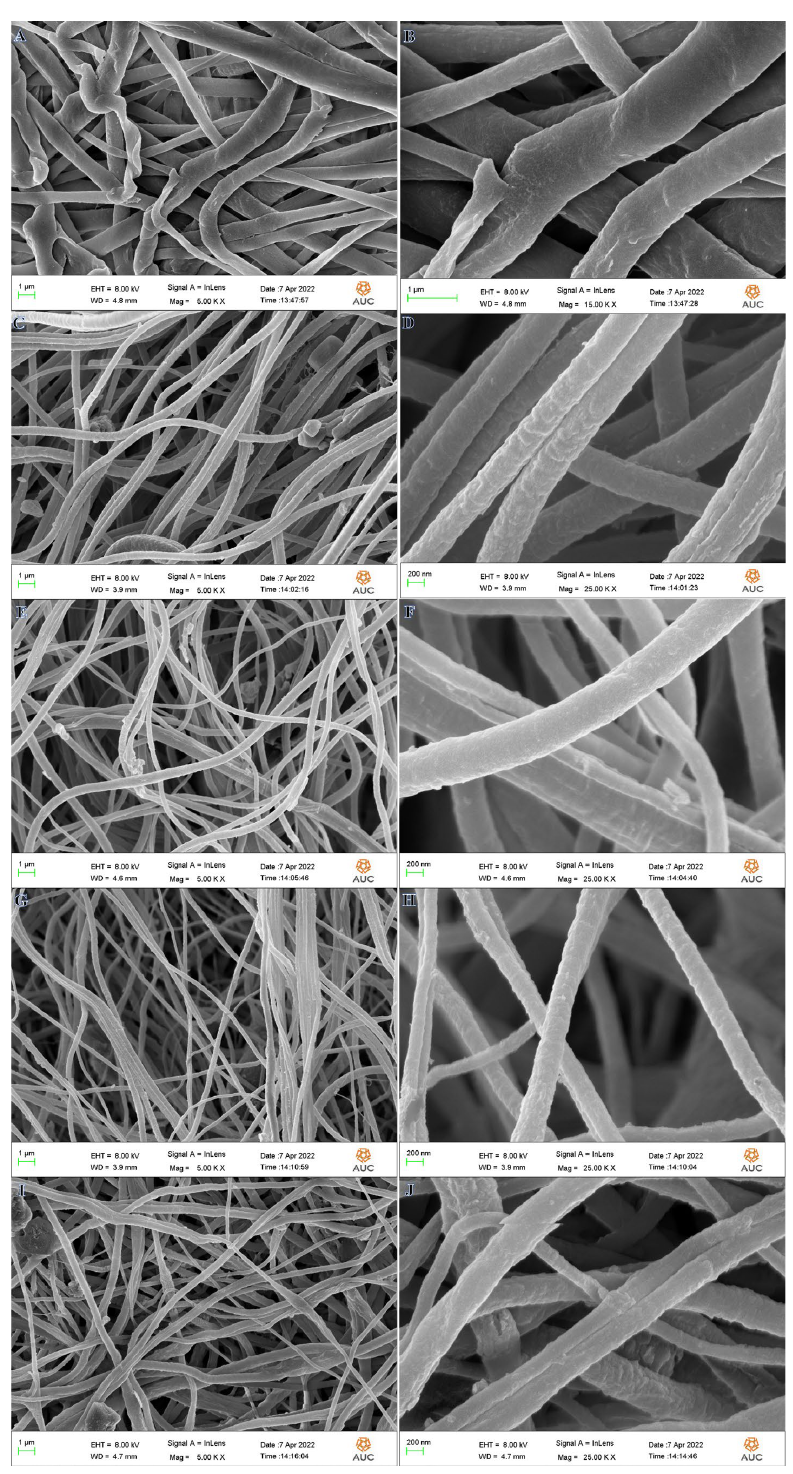
Figure 1. SEM pictures of PVFH ( A , B ), PVFH-10 ( C , D ), PVFH-20 ( E , F ), PVFH-30 ( G , H ), and PVFH-40 ( I , J ) membranes.